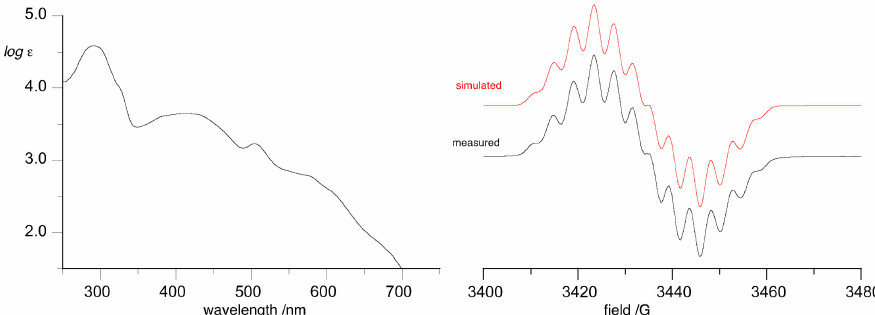
Figure 3. Electronic absorption spectrum in CH 2 Cl 2 ( left ) and ERP spectrum in benzene ( right ) for Ia